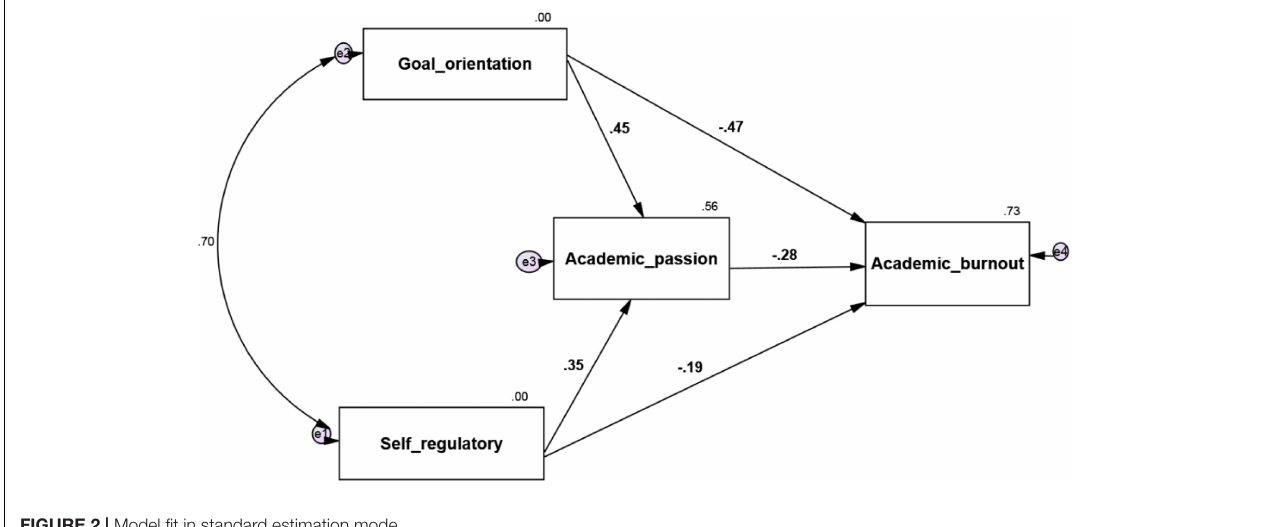
FIGURE 2 | Model fit in standard estimation mode. TABLE 6 | Relationship between self-regulation and academic